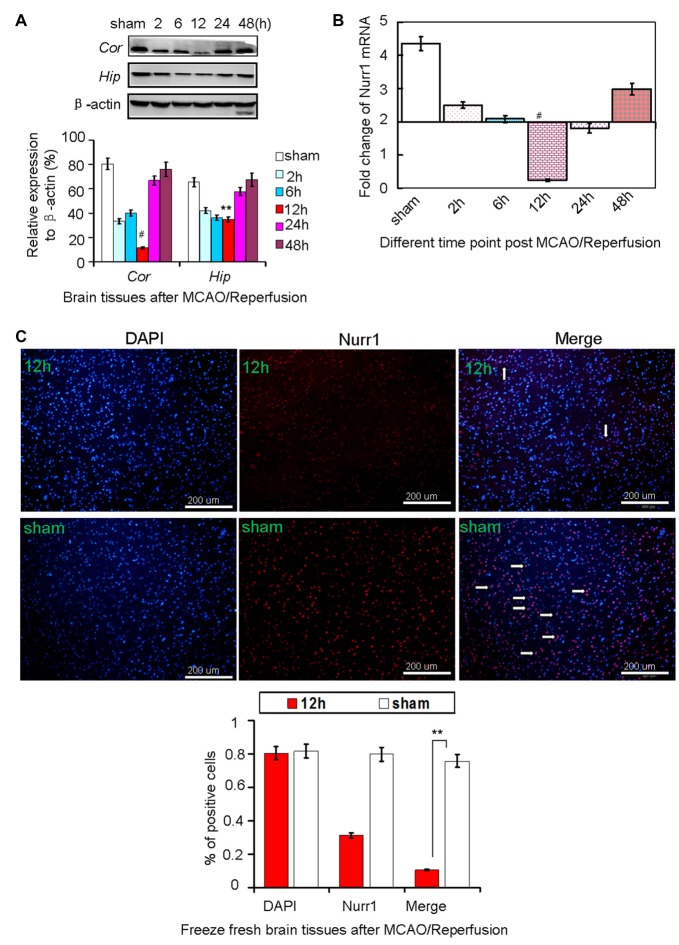
Nurr1 expression at 2, 6, 12, 24 and 48 h after MCAO/R. (A) Nurr1 protein was measured by Western blot at each time point upon cerebral ischemia/reperfusion. The gray intensities of the bands were quantified using ImageJ software and presented as percentage of β-actin (internal control, %). Nurr1 expression decreased sharply and reached a minimum at 12 h in cerebral cortex (Cor) and hippocampus (Hip) of rats. (B) Nurr1 mRNA was measured by RT-qPCR and presented as relative expression (mean ± SD, n = 3). (C) Nurr1 protein expression was significantly declined in the infarct side of cortex by immunofluorescence staining from fresh freeze brain sections 12 h after MCAO/R. **p < 0.01, #p < 0.001.